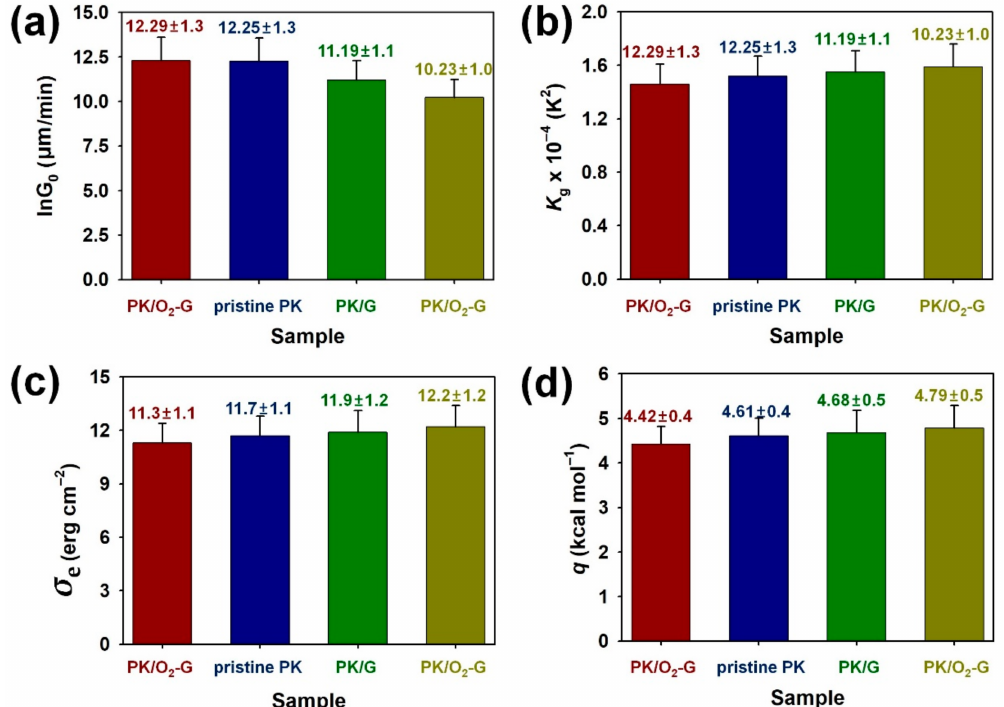
Figure 7. Secondary nucleation and growth parameters from spherulitic growth of PK crystals: ( a ) pre-exponential factor (lnG 0 ), ( b ) secondary nucleation constant ( K g ), ( c ) end surface free energy ( σ e ) and ( d ) chain folding energy ( q ) of PK